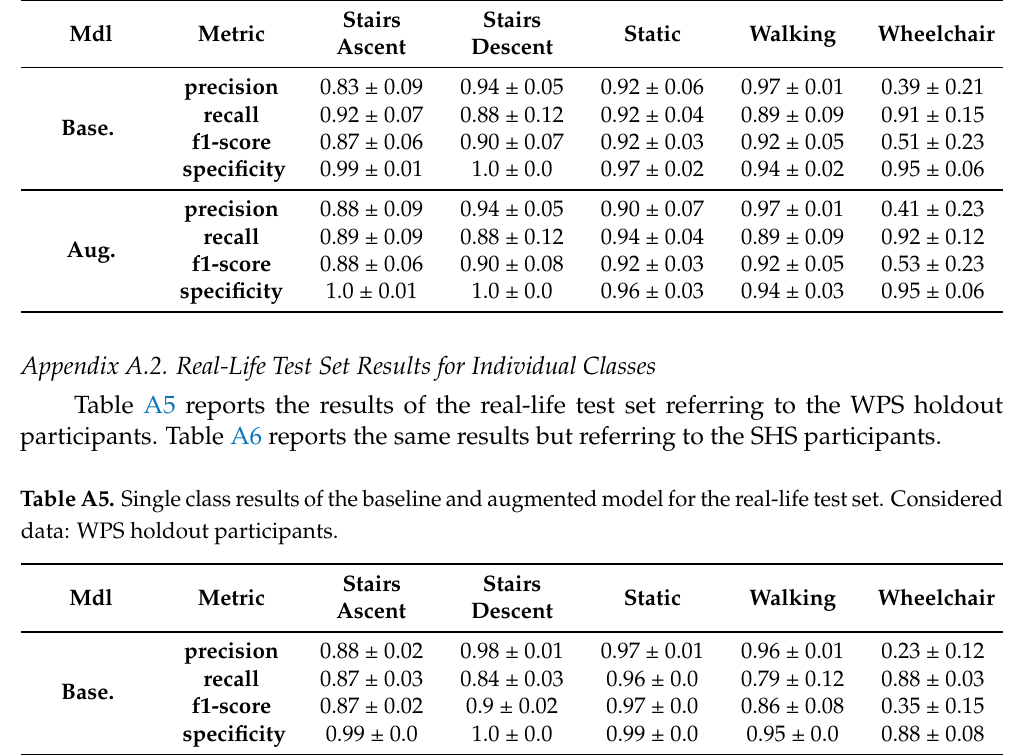
Table A4. Single class results of baseline and augmented model for the original test set. Considered data: SHS participants.